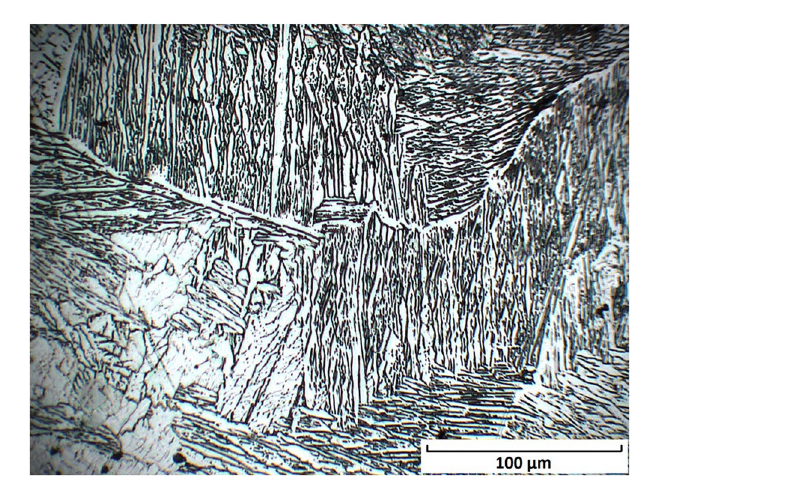
Figure 14. Microstructure morphology at Fe/Cr interface with color